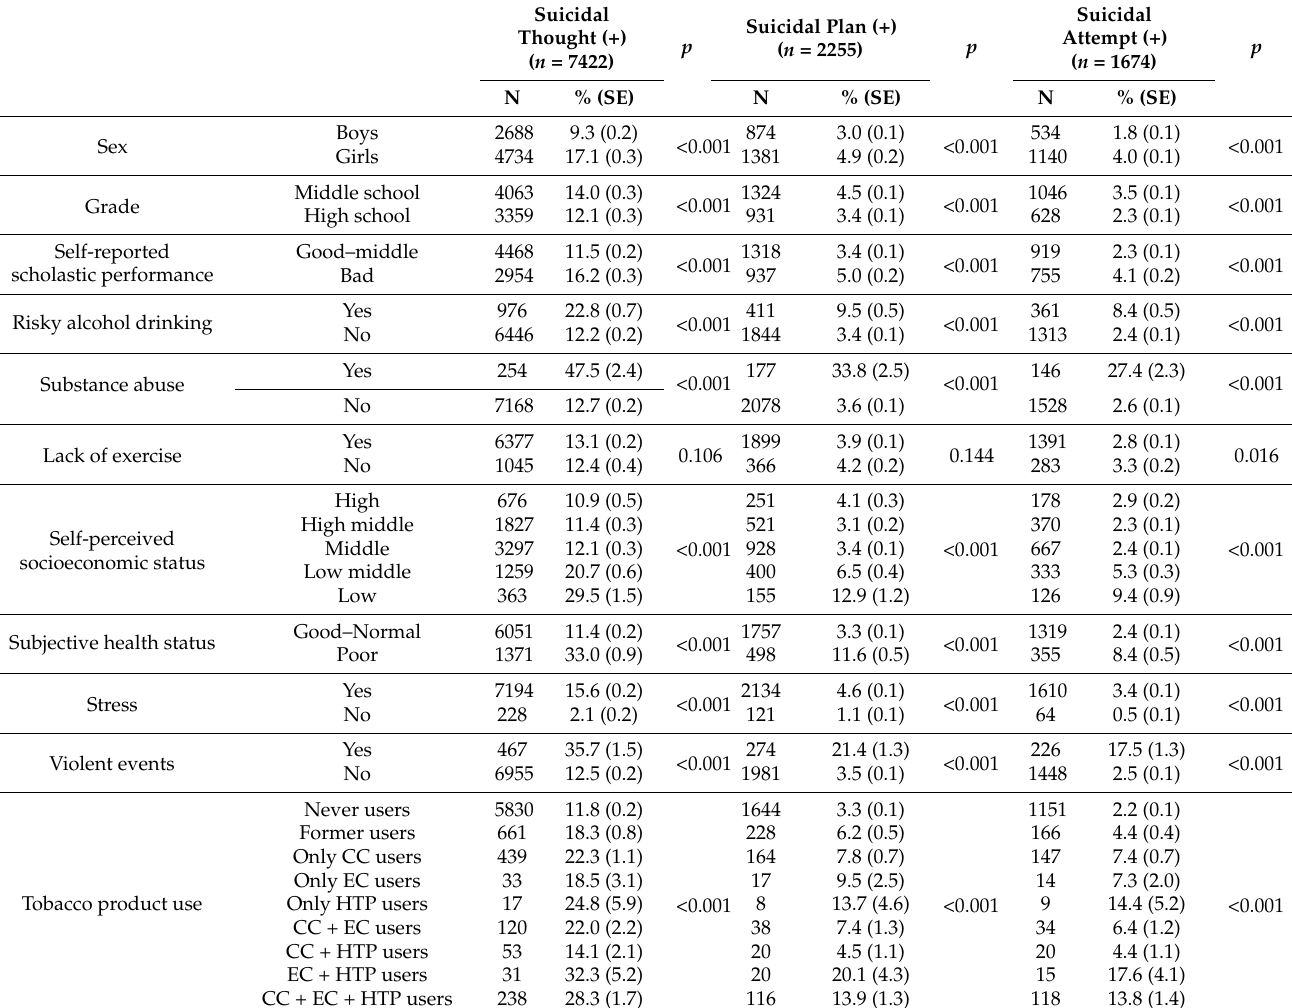
Table 2. Proportion of participants having suicidal thoughts, plans, and attempts according to the type of tobacco